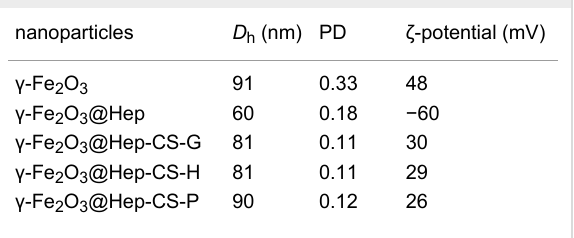
Table 3: Nanoparticle characterization by